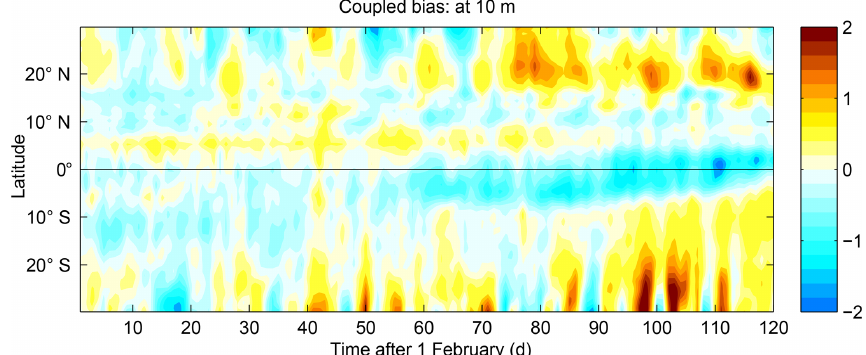
Figure 10. Latitude–time plot showing the evolution of biases in meridional wind in S4 at 10m (within the boundary layer), averaged over longitudes 20–0 ◦ W. Wind speeds are in metres per second and averaged over years 1996 to